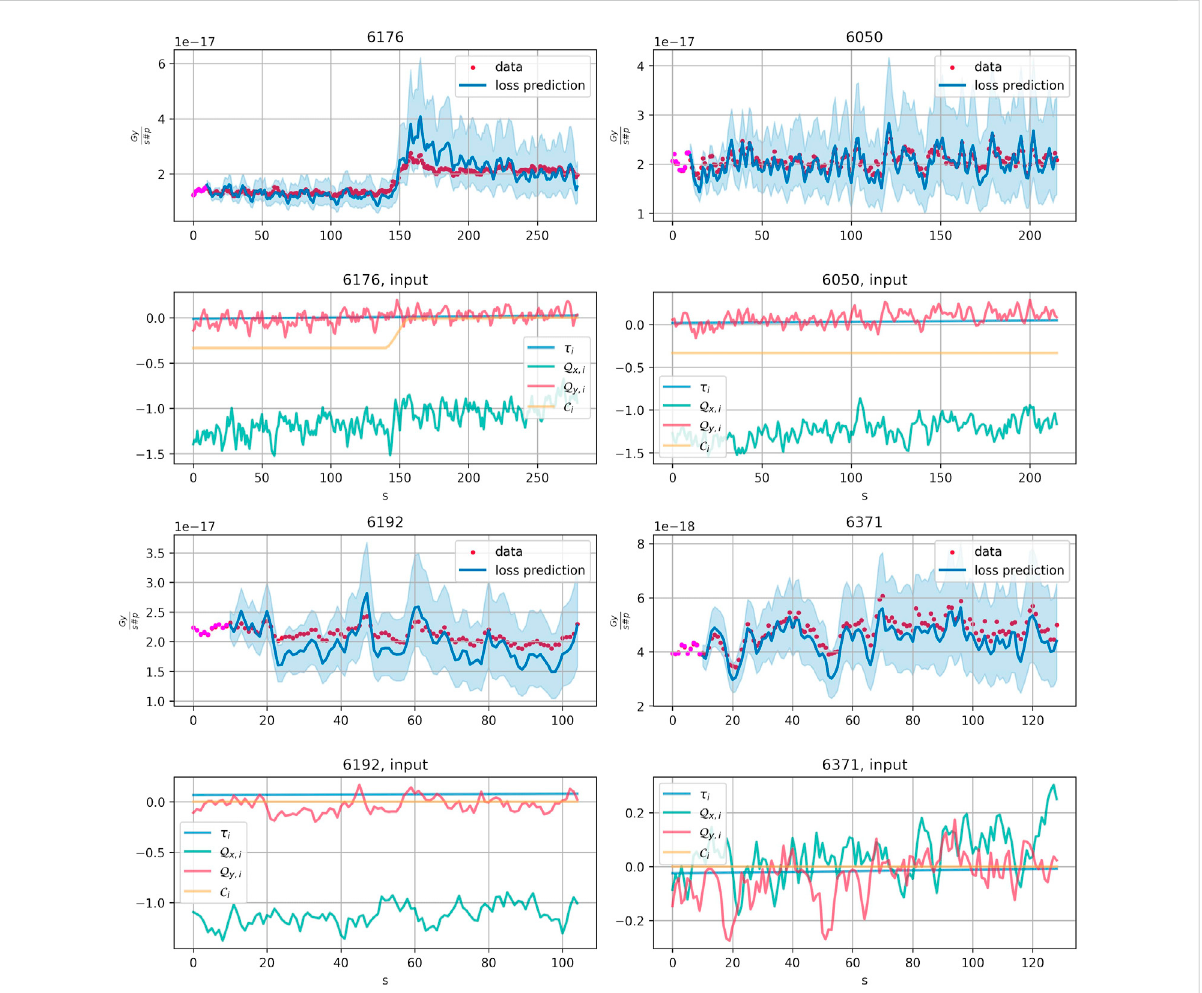
FIGURE 9 KF4 trained on the data of 2017, prediction on the fi lls 6176, 6050, 6192, and 6371 of 2018 and corresponding input control parameters. Pink points correspond to T 0 observations which the model uses to get initial KF smoother results. Further model propagates without seeing the loss and other output values, with control parameters given as the input. Two standard deviation con fi dence bands are shown in light